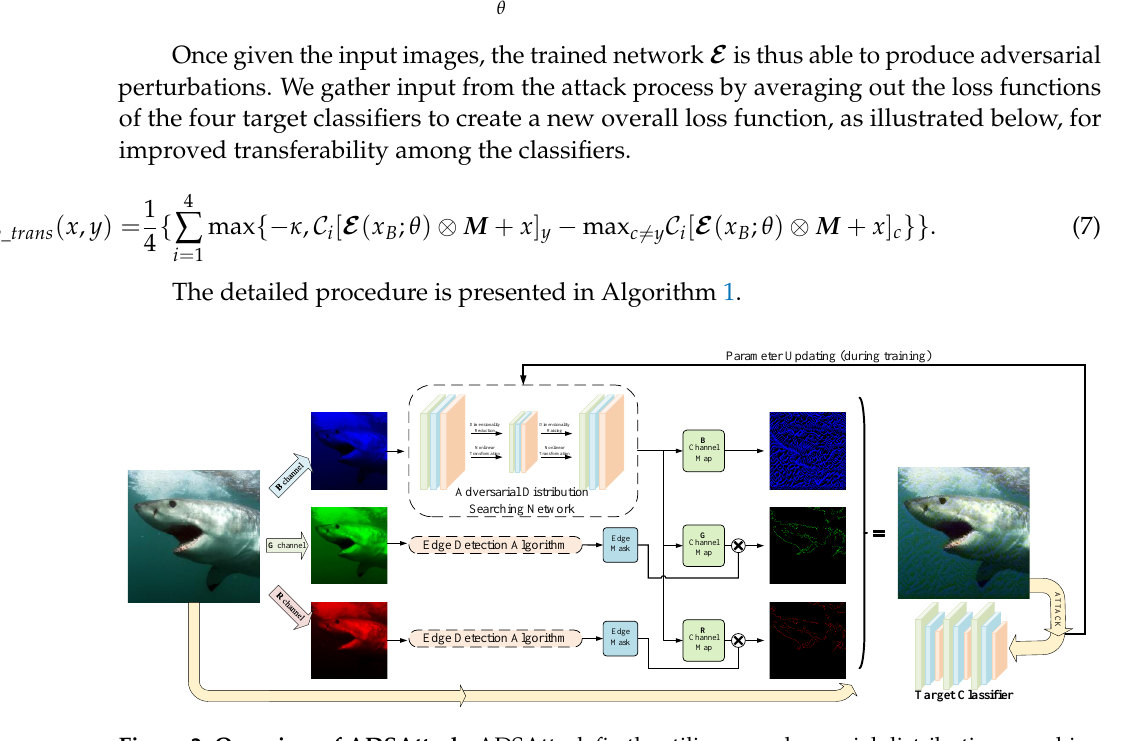
Figure 2. Overview of ADSAttack. ADSAttack firstly utilizes an adversarial distribution searching network to extract feature maps (i.e., channel map in the figure) from the input’s B image channel and locates the edge area information (i.e., edge mask in the figure) from the other two image channels of the input. A perturbation prior is then obtained by applying the elementwise product on the feature maps and corresponding edge masks. Next, the original input with its perturbation prior is fed into the target classifier. Given the designed loss function, the parameters of the adversarial distribution searching network are thus able to be updated for adversarial example